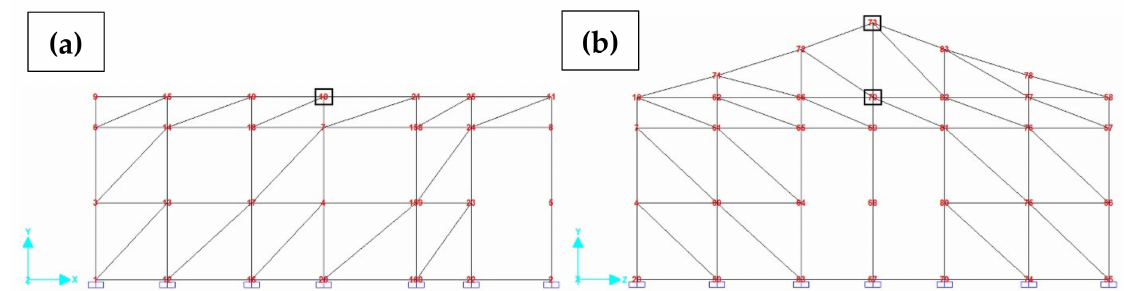
Figure 22. The 3 nodes used for the analysis of the maximum displacements of the undamaged and damage structure. ( a ) Front and back facades. ( b ) Lateral facades [34].